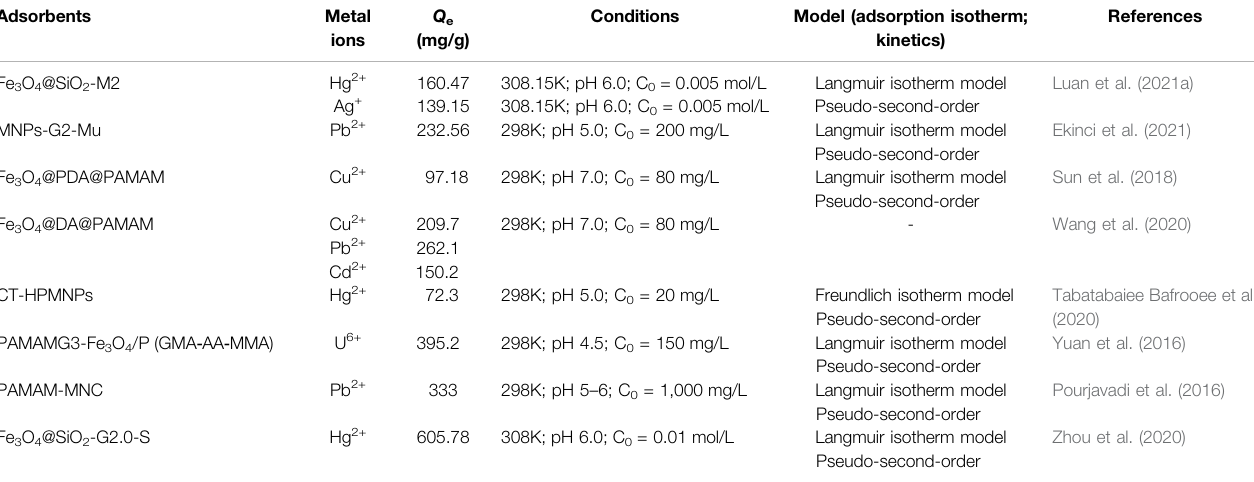
TABLE 2 | Heavy metal ions adsorbed by polyamide amine/magnetic nanomaterial composites.